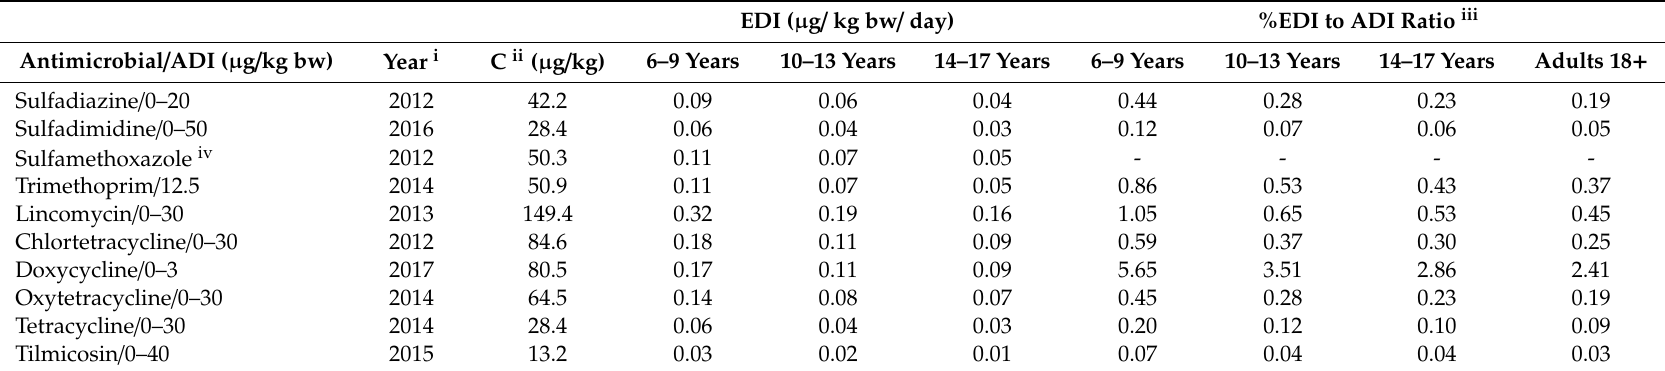
Table 5. Estimated daily intake values (EDI) and percentage of EDI to acceptable daily intake (ADI) ratio for female children and adolescents using the maximum geometric mean